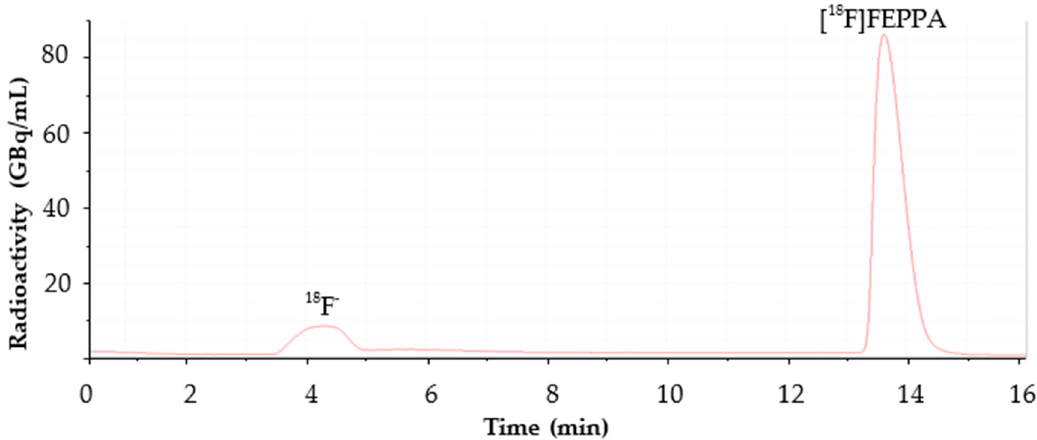
Figure 2. Semi-preparative HPLC radiochromatogram.